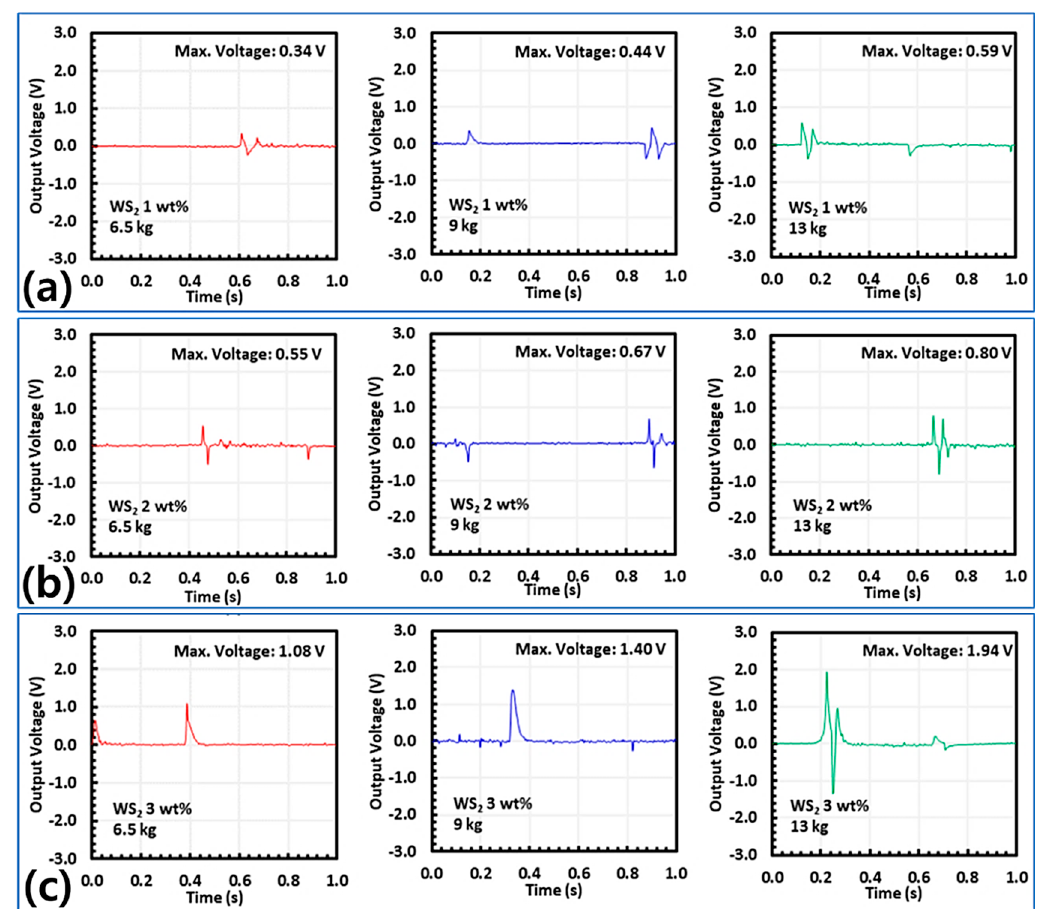
Figure 6. Output voltage (V) of the FWPG with various proportions of WS 2 and pressing conditions: ( a ) 1 wt%, ( b ) 2 wt%, and ( c ) 3 wt%.